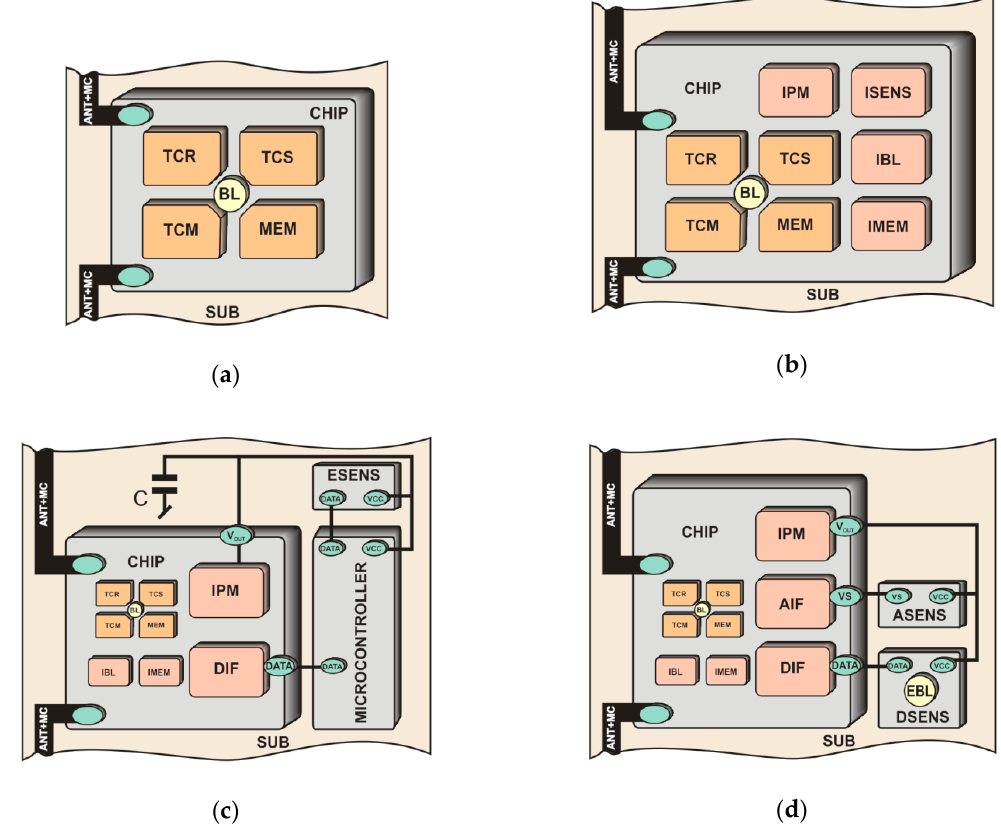
Figure 3. Di ff erent concepts of RFID sensors: ( a ) A typical passive transponder; ( b ) Passive transponder with sensor on chip; ( c ) Digital platform with passive transponder; ( d ) Passive transponder with analog or digital sensor interface. TCM, TCR, TCS—respectively: modulator, rectifier,